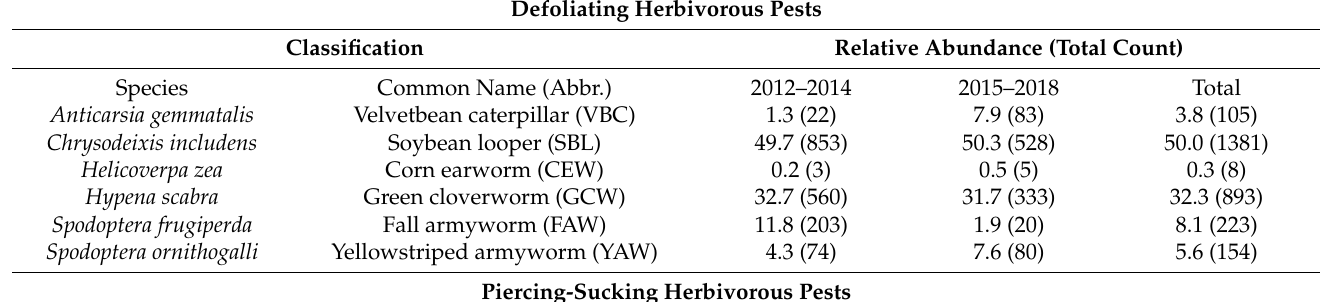
Table 2. Relative abundance and total count data for collected pest groups, defoliating and piercing- sucking herbivores,